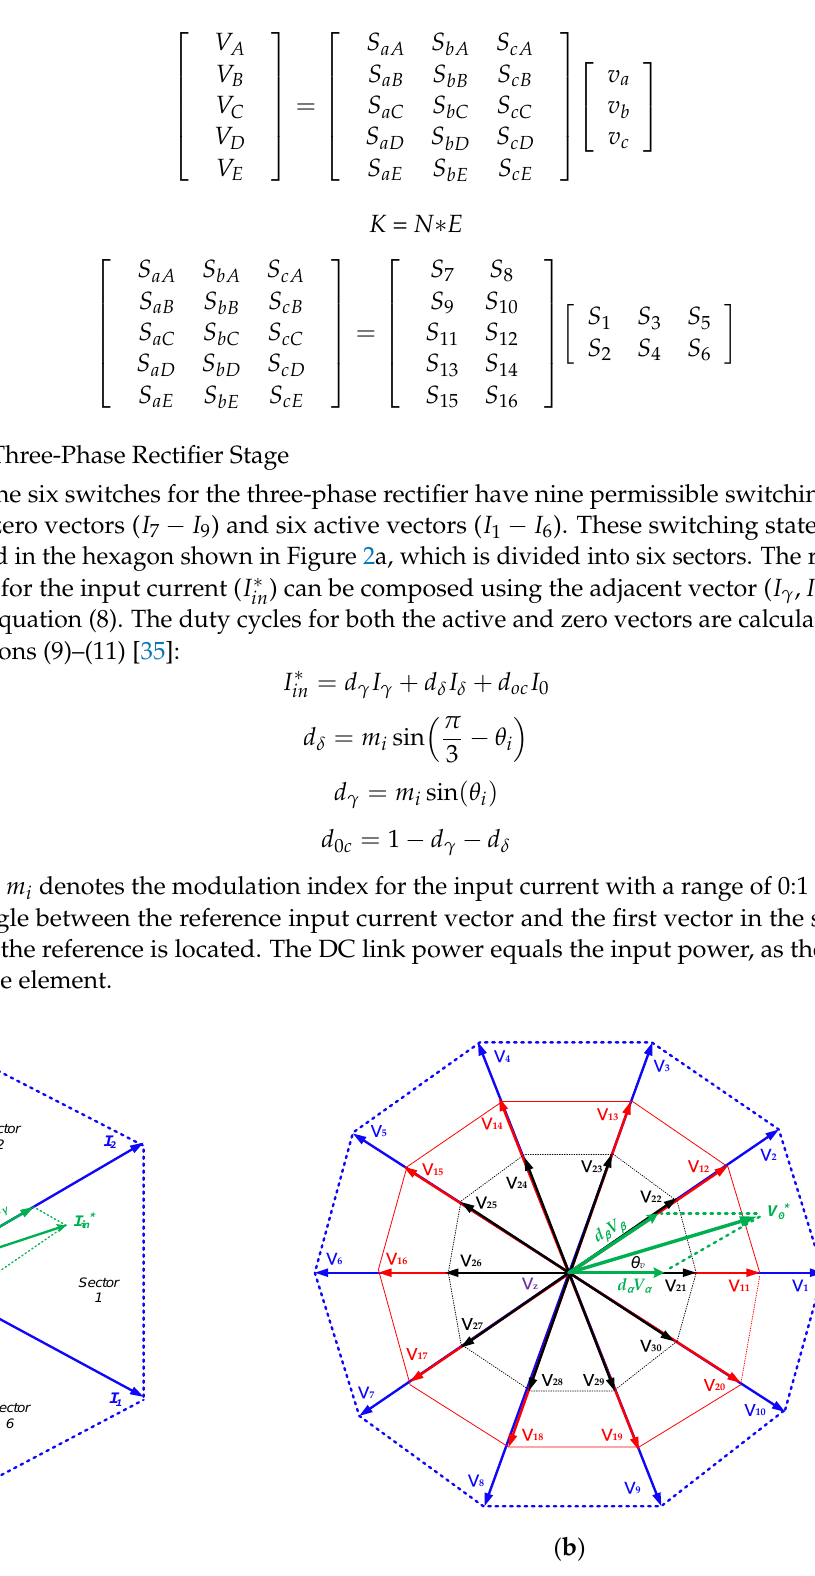
Figure 2. ( a ) Hexagon of the rectifier and ( b ) decagon of the inverter.